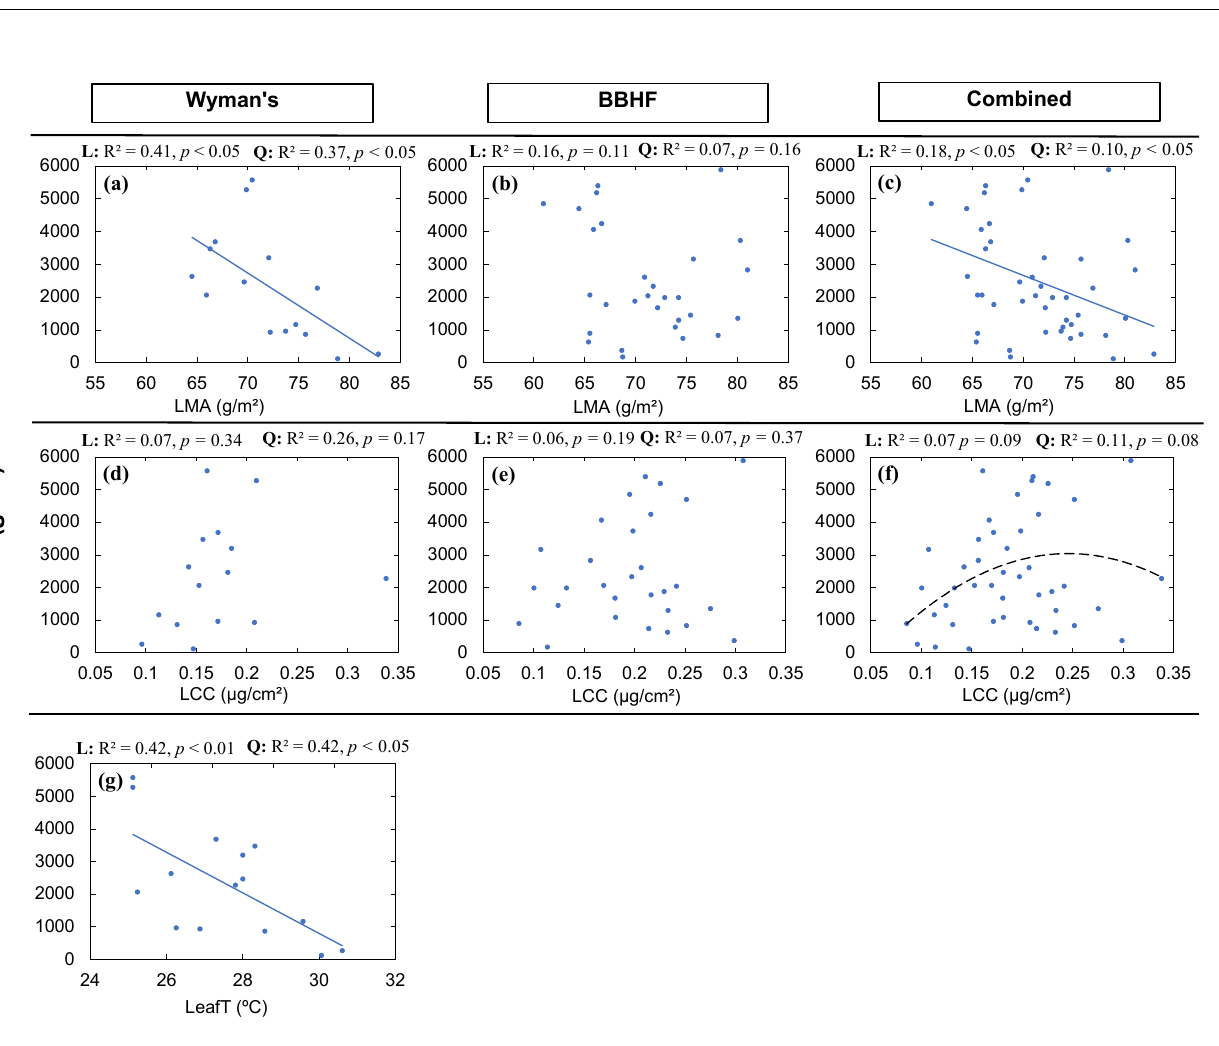
Figure 4 . Yield (g/m²) of wild blueberry fields in relation to leaf mass per area (LMA) ( a – c ); leaf chlorophyll concentration(LCC) ( d – f ) and leaf temperature (LeafT) ( g ). The solid lines indicate significant ( p < 0.05) linear relationships, and black lines indicate significant ( p < 0.05) quadratic relationships. Dashed lines indicate marginally significant ( p < 0.10) relationships. Here among all the structural and functional traits, only significant or marginally significant relationships to yield were plotted. The strongest relationship was chosen by the high level of significance ( p -value) and higher coefficient of determination (R 2 ). For definitions of trait abbreviations, please see Table 1. We found relationships of the average number of berries (NBS) with StemL, LCC, LMA, LAPS, and SoilT, but they were not consistent within and across fields (Figures 3 and 5). We found a marginally significant linear (Figure 5a: R² = 0.21, p = 0.08) and quadratic (Figure 5a: R 2 = 0.33, p = 0.08) relationship between NBS and StemL among the genotypes in the Wyman’s field. Significant relationships were absent for the BBHF field and when the two fields were combined. We did not find any significant linear or quadratic relationships between LCC and NBS for Wyman’s wild blueberry field (Figure 5d) but found significant positive linear relationships for the BBHF field (Figure 5e: R² = 0.17, p < 0.05) and combined data (Figure 5f: R² = 0.17, p < 0.05). For the combined data, we also found a significant quadratic relationship (Figure 5f: R² = 0.21, p < 0.01), but for the BBHF field, the quadratic relationship was borderline significant (Figure 5e: R² = 0.18, p = 0.07). We found significant negative linear relationships between NBS and LMA for Wyman’s field (Figure 5g: R² = 0.43, p < 0.01) and the combining data for the two fields (Figure 5i: R² = 0.09, p < 0.05), but no significant relationship for the BBHF field. While comparing the leaf structural trait average leaf area per stem (LAPS) with NBS, only a significant quadratic relationship was found for the BBHF field (Figure 5k: R² = 0.20, p < 0.05). We also found significant linear (Figure 5m: R² = 0.35, p < 0.05) and quadratic relationships (Figure